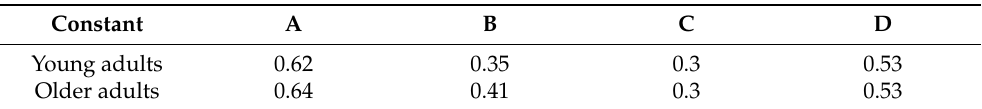
Table 2. Optimised values of the MPMV model